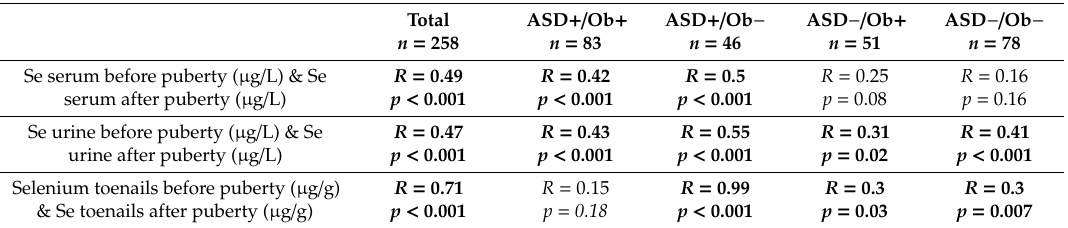
Total ASD +/ Ob + ASD +/ Ob − ASD − / Ob + ASD − / Ob − n = 258 n = 83 n = 46 n = 51 n = 78 R = 0.49 R = 0.42 R = 0.5 R = 0.25 R = 0.16 p < 0.001 p < 0.001 p < 0.001 p = 0.08 p = 0.16